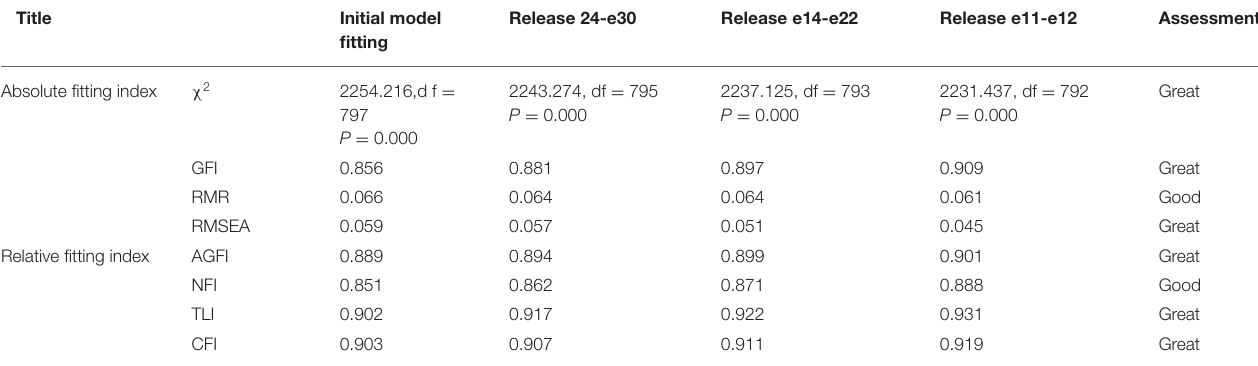
TABLE 8 | Overall fitting degree indices of each